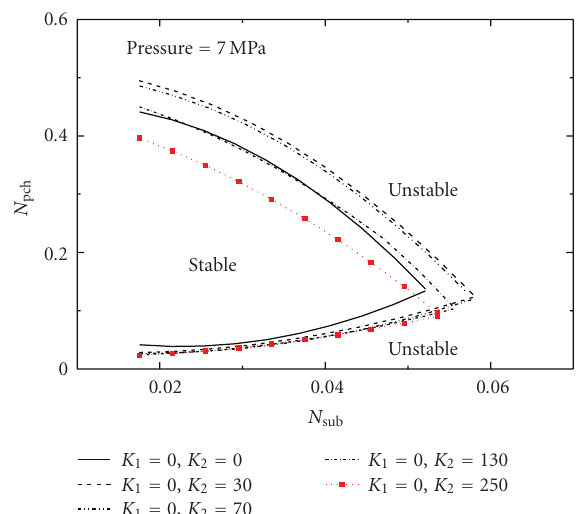
Figure 18: E ff ect of orificing of channels on the stability of boiling natural circulation systems ( K 1 and K 2 refer to the throttling coe ffi cients of channel 1 and 2, resp.).